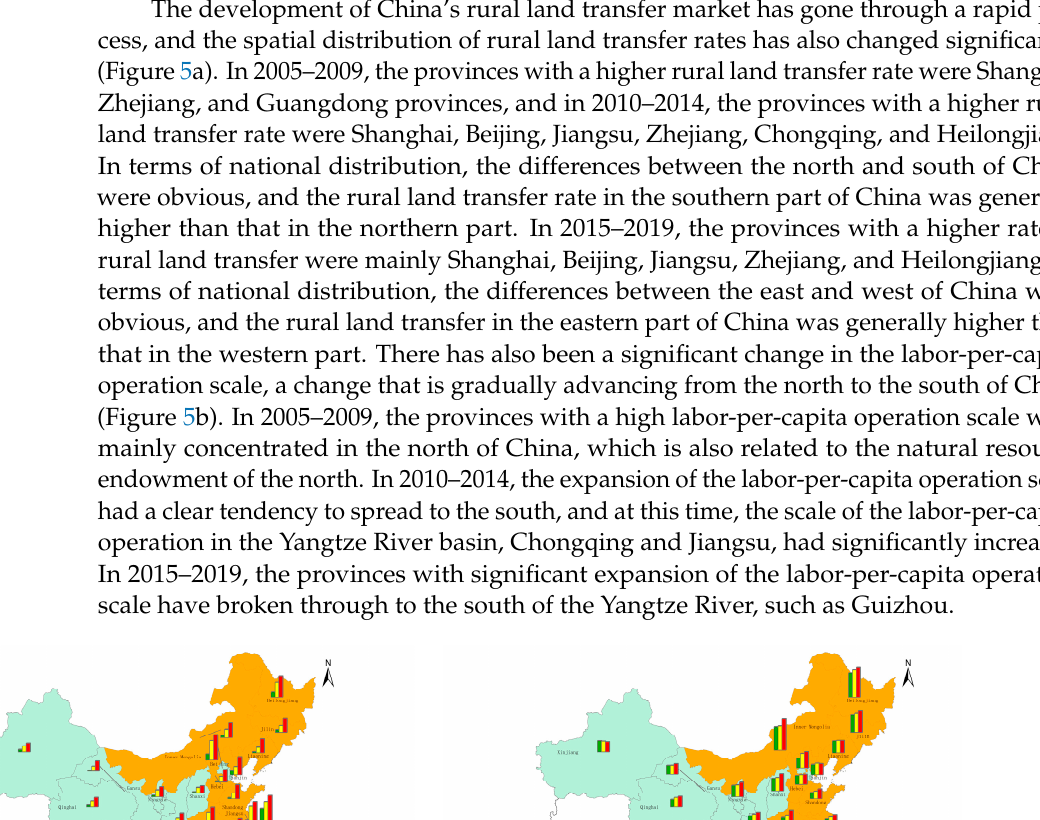
Figure 4. Frequency diagram of the distribution: ( a ) the value of rural land transfer rate; ( b ) the value of labor-per-capita operation scale; * 1 Mu = 1/15 Ha.